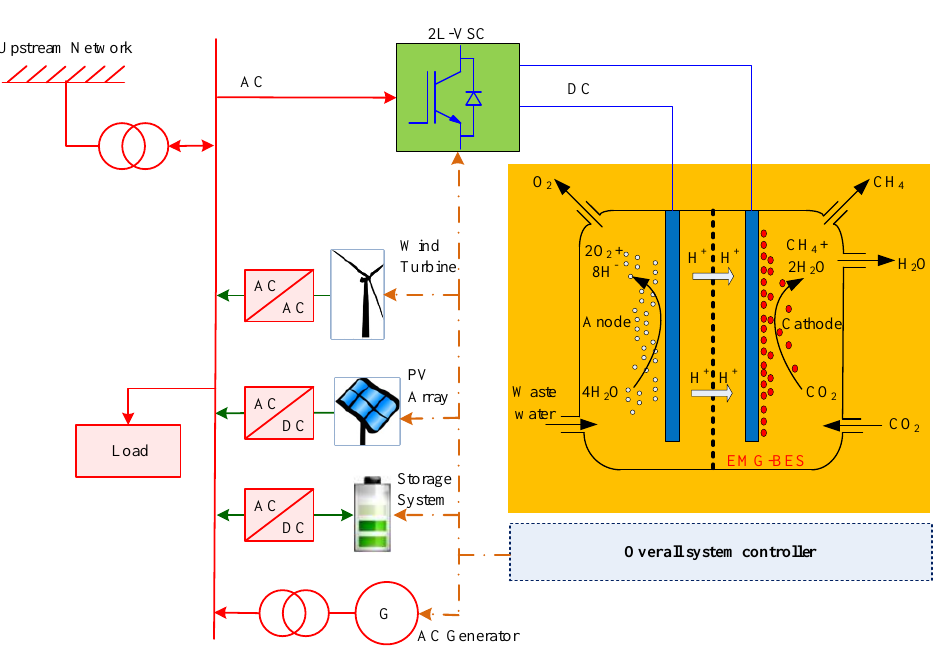
Figure 1. Schematic of a microgrid with bioelectrochemical power to gas station.